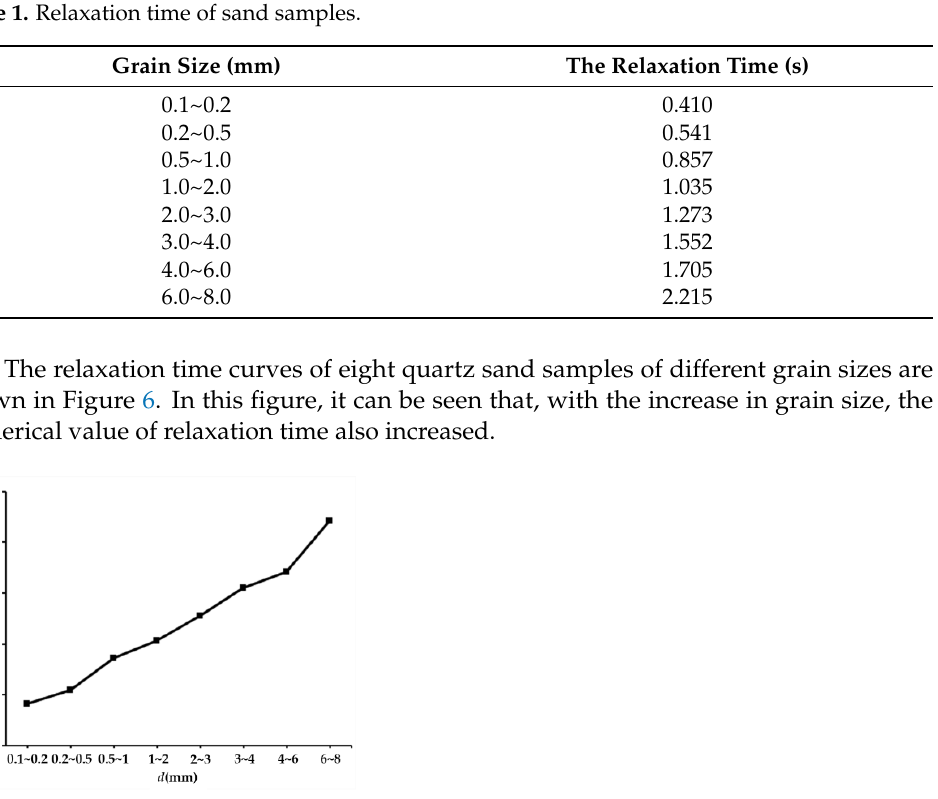
Figure 6. Relaxation time of sand samples.